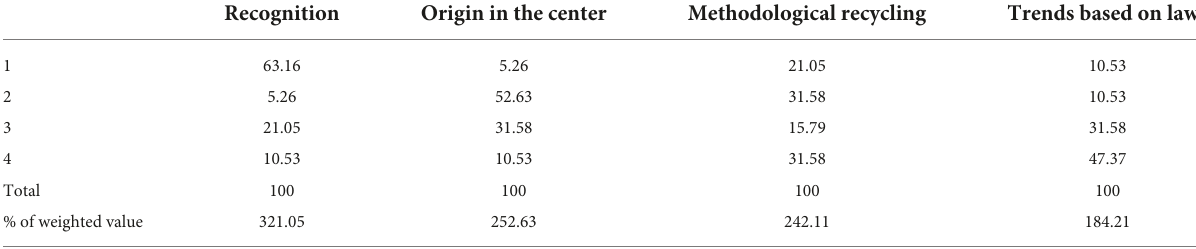
TABLE 10 Opinions on external pressures affecting educational innovation, from highest to lowest priority.